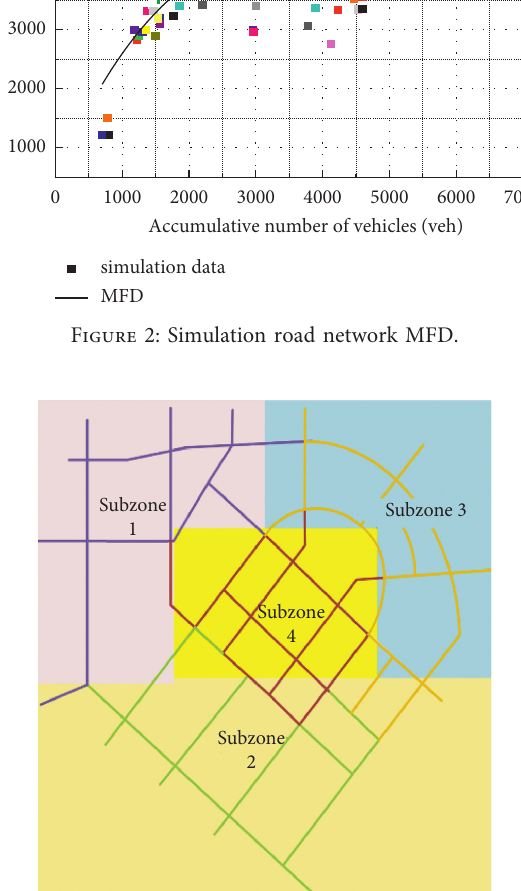
Figure 3: Road network subzone division